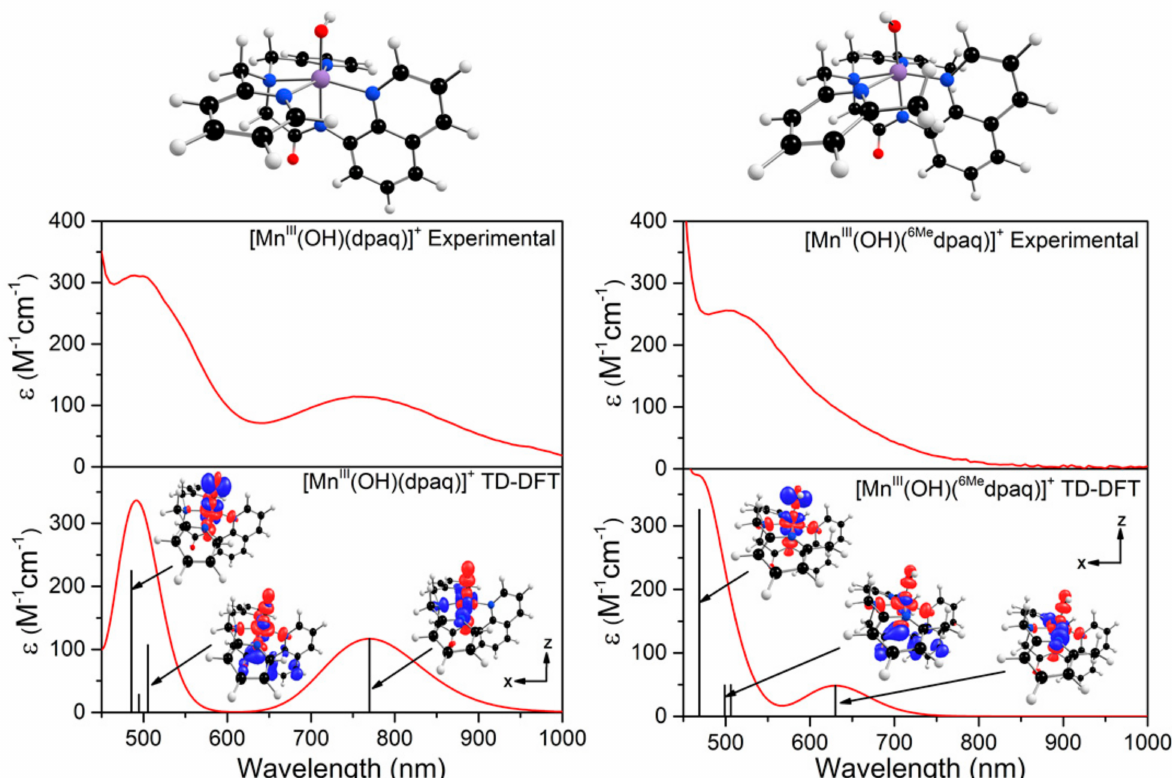
Figure 4. TD-DFT-computed electronic absorption spectra for [Mn III (OH)(dpaq)] + ( left ) and [Mn III (OH)( 6Me dpaq)] + ( right ). The sticks indicate electronic transitions; EDDMs of selected transitions are included as an inset. Red and blue colors in the EDDMs denote gain and loss of electron density, respectively. The DFT-computed structures of the Mn III -hydoxo complexes are shown above the absorption